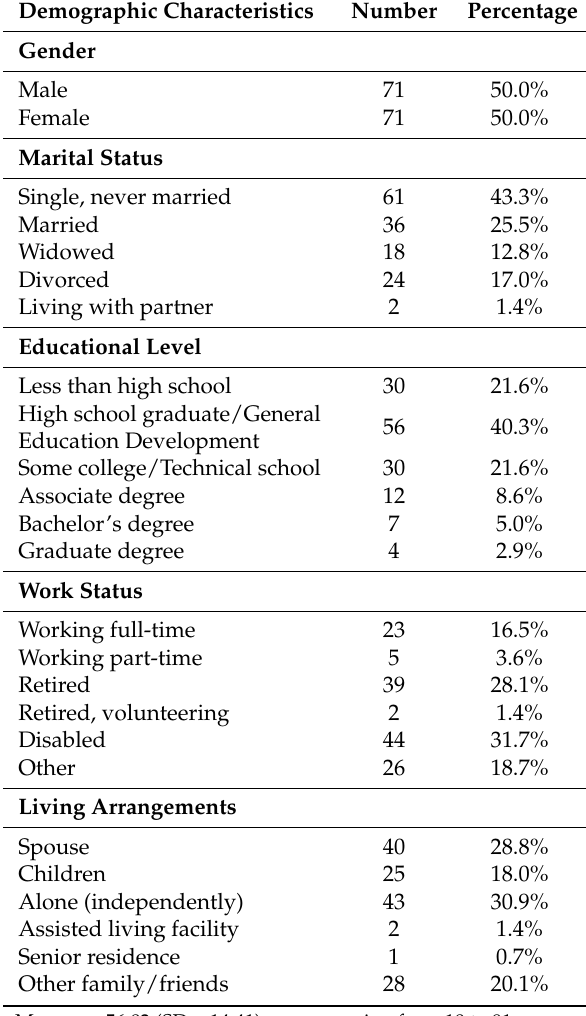
Table 1. Frequency distributions of demographic characteristics of the sample ( N =